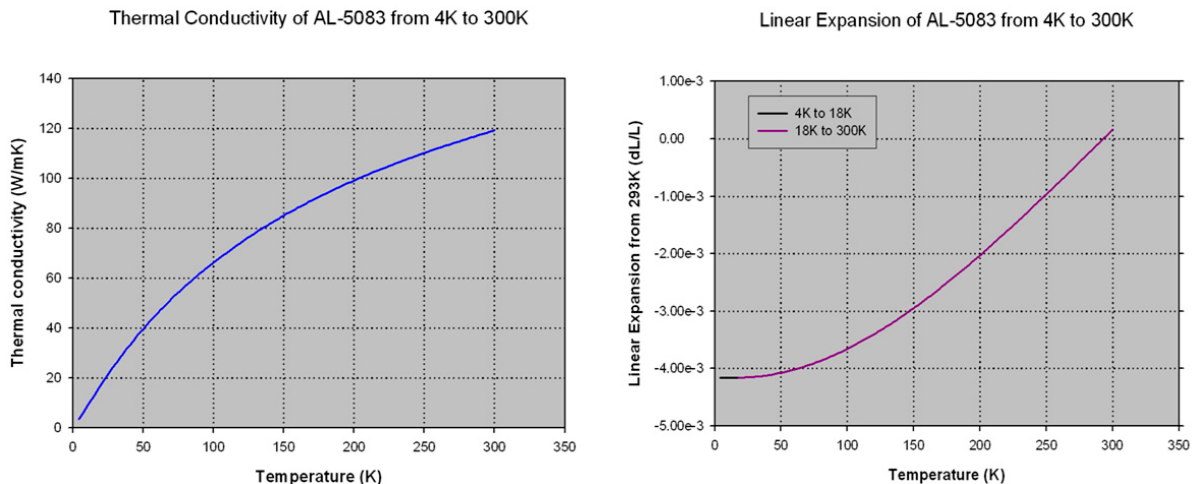
Figure 2. Variation in the thermal conductivity and linear expansion of aluminum 5083 [11].